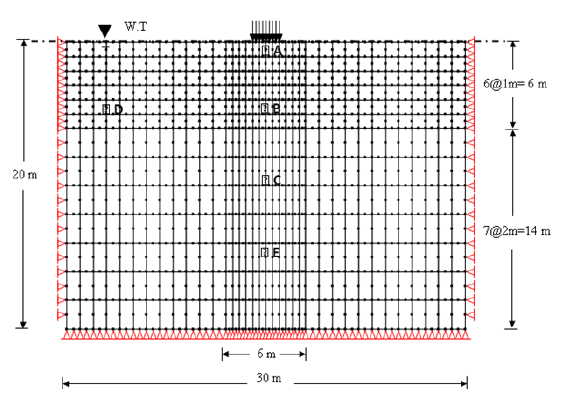
Figure 2. Shear modulus reduction function (Seed and Idriss, 1970) [16].